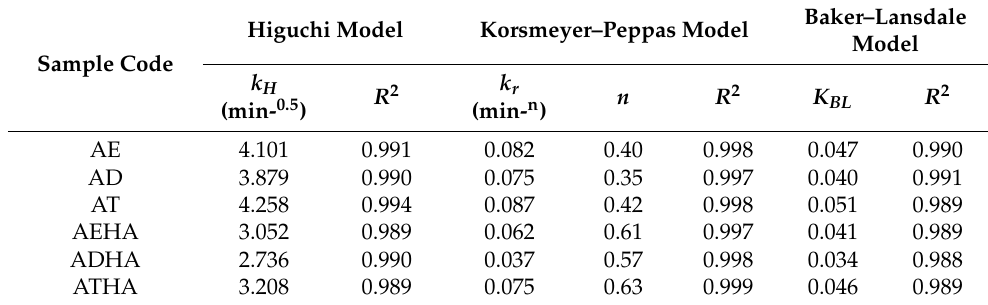
Table 13. Kinetic release parameters of metronidazole pH =